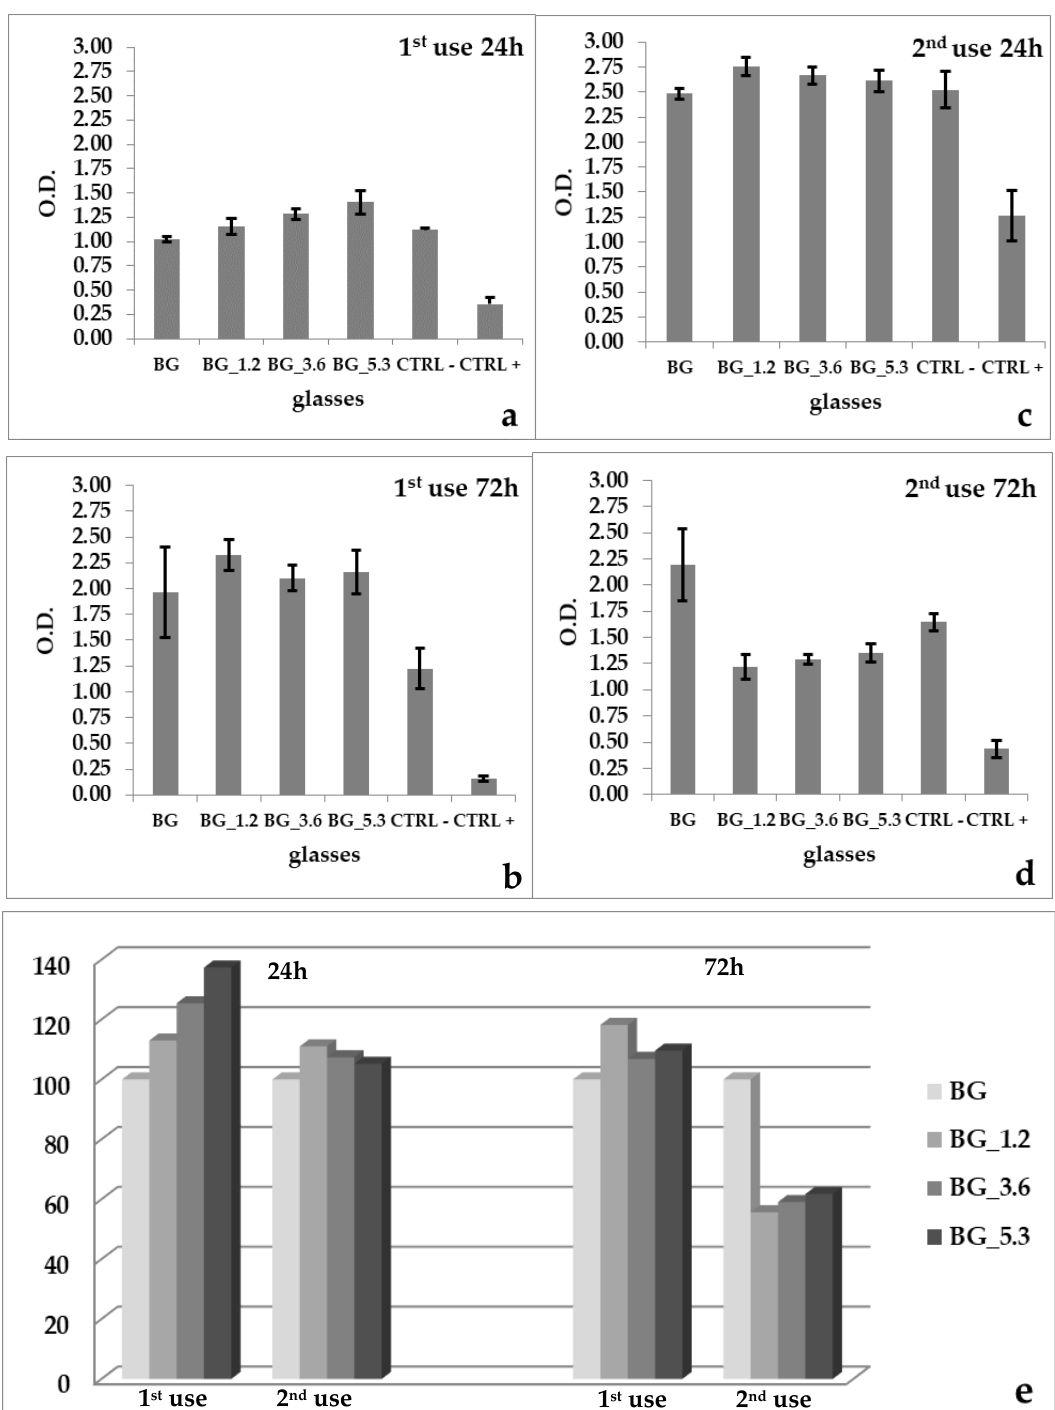
Figure 2. 3-(4,5-Dimethylthiazol-2-yl)-2,5-diphenyltetrazolium bromide (MTT) uptake with MLOY4 cell lines after ( a , c ) 24 h, ( b , d ) 72 h for BG, BG_1.2, BG_3.6 and BG_5.3, together with negative (CTRL − ) and positive (CTRL + ) controls; errors bars represent standard deviation. Comparison between doped glasses among the first and second use, after 24 and 72 h ( e ).